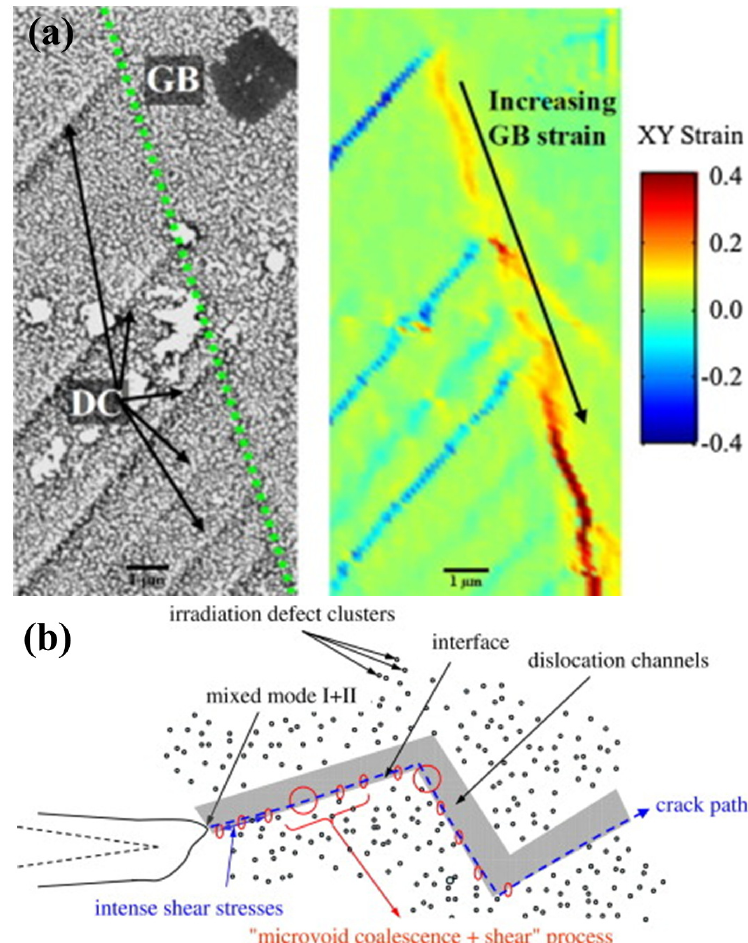
Figure 10. (color online) ( a ) The interaction between dislocation channels and grain boundaries that results in stress concentration due to the pile-up of dislocations by grain boundaries and transmission of dislocations through grain boundaries. (Reprinted with permission from [129]. Copyright 2015 by Elsevier.) ( b ) Illustration of the propagation of crack tip along the interface of dislocation channels. (Reprinted with permission from [130]. Copyright 2007 by